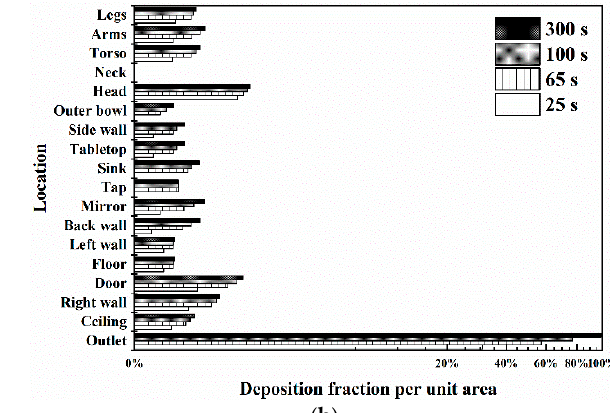
Figure A2. Final deposition of bioaerosols per unit area for Case 2 by size: ( a ) 1 µm; ( b ) 5 µm; ( c ) 10 µm.